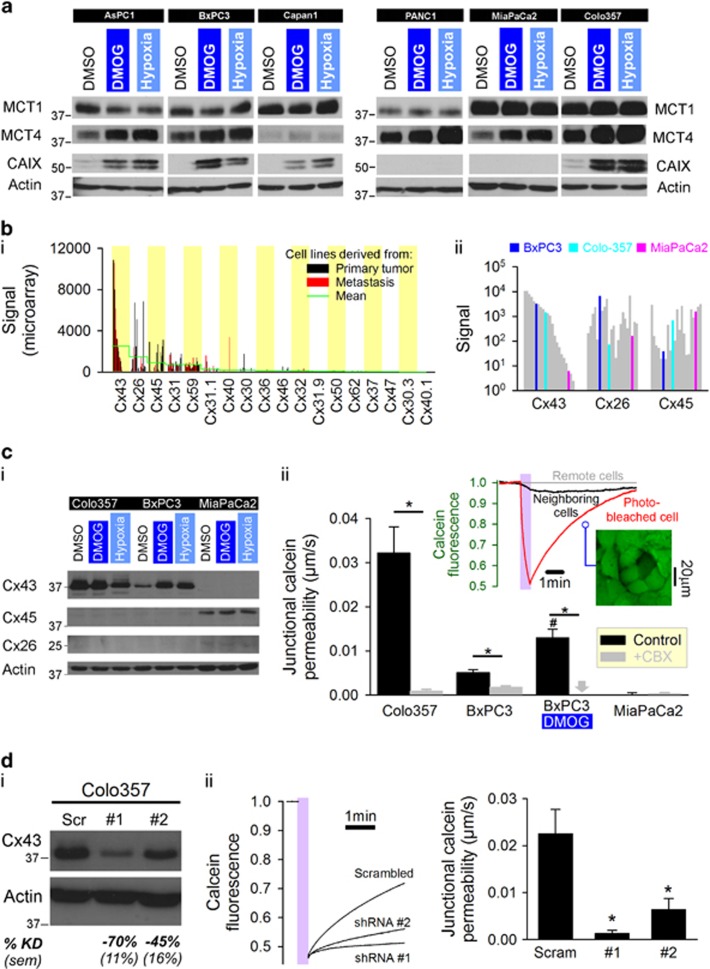
Gap junctional connectivity in PDAC cells. (a) Western blot (one of three repeats) for MCT1 and MCT4; CAIX induction is used as a marker of hypoxic signalling. (b(i)) Microarray data (BioGPS dataset E-GEOD-21654) for expression of connexin-coding genes in PDAC cell lines (see Supplementary Information for list; note that Cx23, Cx25 and Cx30.2 were not determined). (ii) Expression re-plotted on logarithmic scale, highlighting data for BxPC3, Colo357 and MiaPaCa2 cells. (c,i) Western blot (one of four repeats) for Cx43, Cx45 and Cx26 under normoxic conditions, after treatment with 1 mm dimethyloxalylglycine (DMOG), and incubation in 2% O2 (hypoxia). (ii) Fluorescence recovery after photobleaching (FRAP) protocol for measuring junctional calcein permeability. Specimen trace for Colo357 monolayer. Carbenoxolone (CBX; 100 μm) inhibited coupling. Mean±s.e.m. of 15 Colo357, 15 BxPC3 and 10 MiaPaCa2 cell clusters. Unpaired t-test *P<0.01 (control vs CBX), #P<0.01 (DMOG vs normoxia). (d(i)) shRNA knockdown of Cx43 (GJA1 gene) in Colo357 (lentiviral delivery) reduces Cx43 expression; two constructs (of four tested) with best knockdown efficiency are shown. Knockdown efficiency (% KD) determined densitometrically from the change in Cx43/actin ratio from three blots (mean±s.e.m.). (ii) Cx43 knockdown reduces cell-to-cell coupling assayed by FRAP. Note that enhanced green fluorescent protein (eGFP) signal associated with lentivirally-infected cells, is negligible (<10%) compared with calcein fluorescence and does not contribute to fluorescence recovery. Specimen time courses shown; histogram shows mean±s.e.m. (n=11, 8, 9); unpaired t-test *P<0.01.